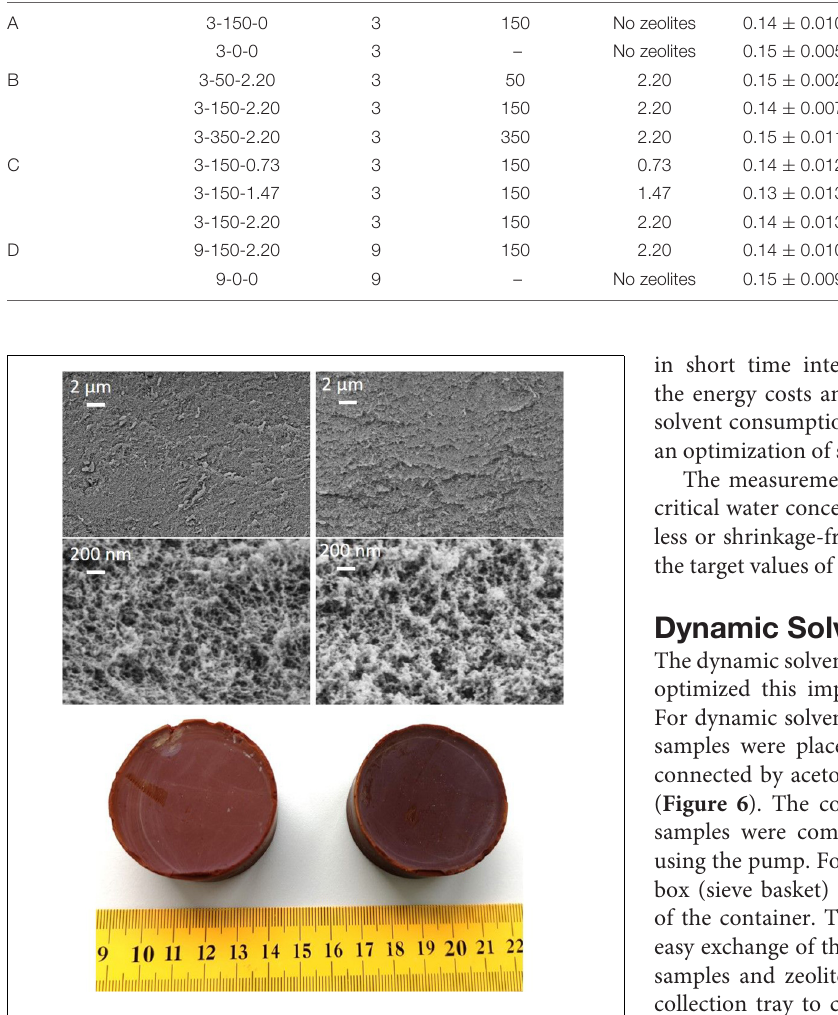
FIGURE 4 | (left) SEM images with different magnifications and a photograph of dynamic (with pump and zeolite) washed RF aerogel; (right) SEM images with different magnifications and a photograph of static washed RF